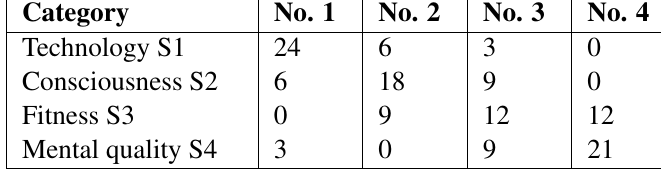
Table 2 The statistical results of experts ranking the importance of the four main